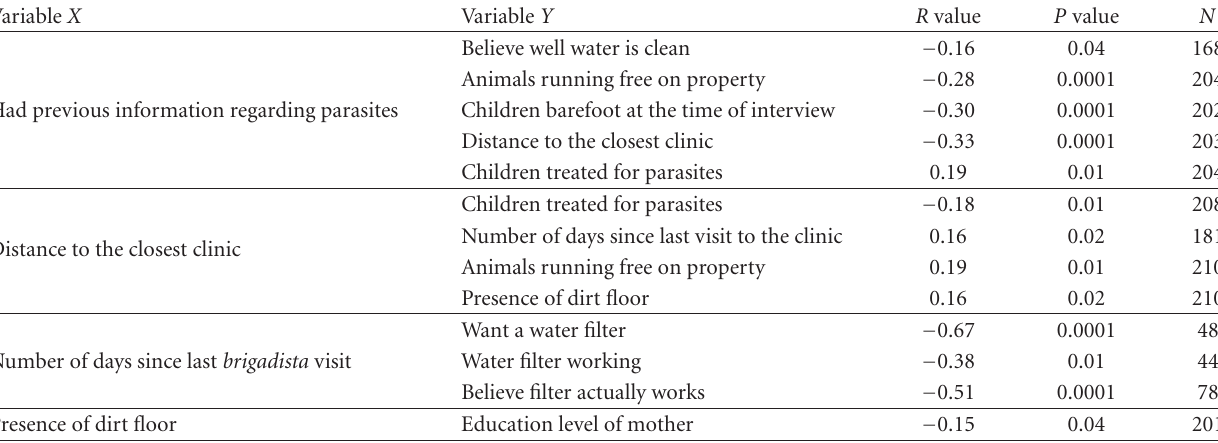
Table 4: Correlations among access to resources variables.